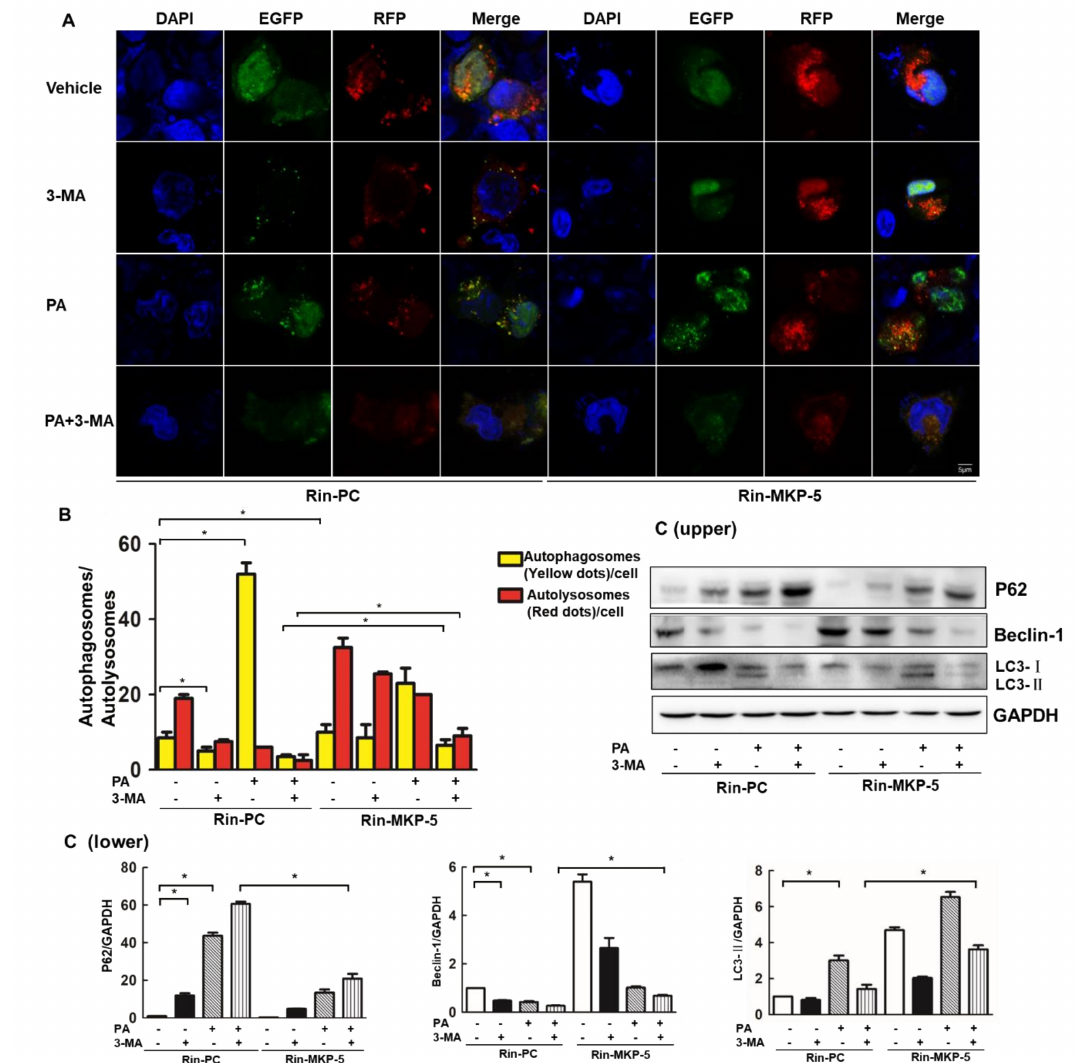
Figure 5. MKP-5 regulates the PA-induced impairment of autophagic flux in Rin-m5f cells. ( A ) Rin-PC and Rin-MKP-5 cells were transfected with the ptfLC3 plasmid for 48 h, after which they were treated with PA and 3-methyladenine (3-MA) for 9 h, and analyzed by laser scanning confocal fluorescence microscopy (scale bar = 5 µ m). ( B ) Quantification of cells positive for red fluorescent protein (mRFP) (red) and mRFP / GFP (green fluorescent protein, yellow) in Rin-PC and Rin-MKP-5 cells transfected with ptfLC3 prior to a 9 h treatment with PA or 3-MA alone or in combination with one another. ( C ) The levels of autophagic proteins in Rin-m5f cells treated with PA ± 3-MA for 9 h were measured by Western blotting (upper) and quantitative analysis was conducted using Image J (lower). *, p < 0.05, 3-MA vs. Vehicle; PA vs. Vehicle; Rin-PC vs.